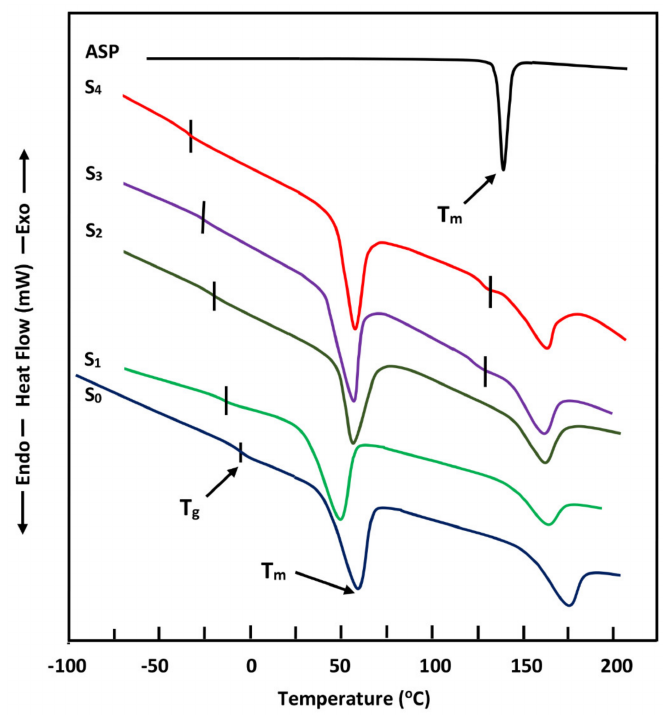
Figure 5. DSC thermograms of: ASP, PE- co -VAL/P δ VL50 and ASP/PE- co -VAL/P δ -VL50 containing Table 3. Variation of T g , T m and T c of the blends versus the